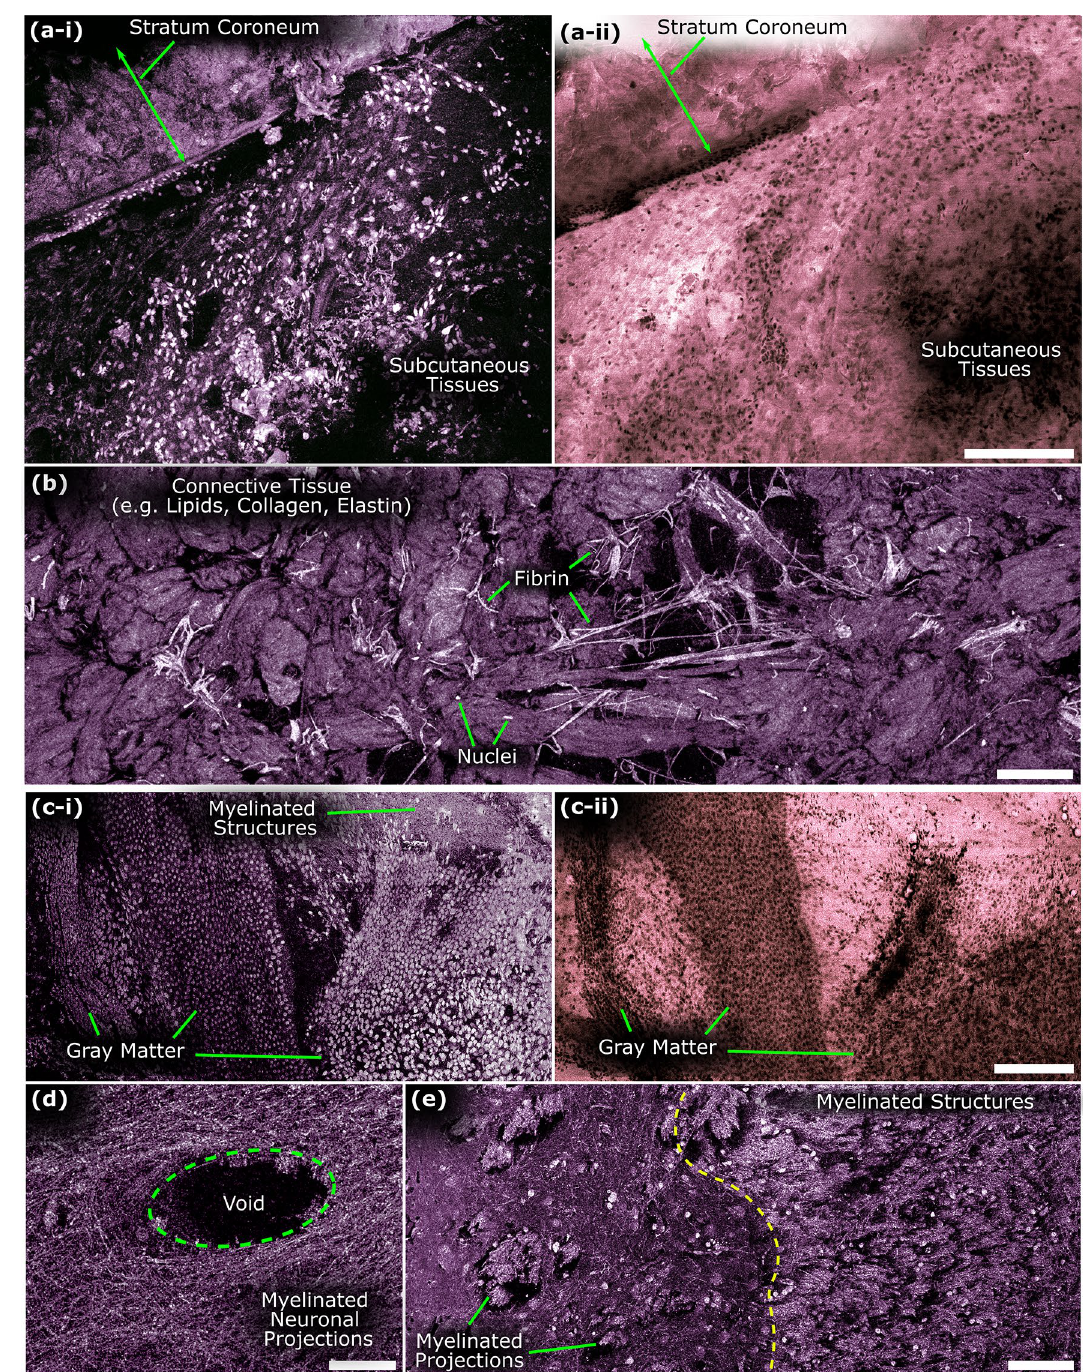
Figure 4. Total-absorption second-generation photoacoustic remote sensing (TA-PARS) microscopy of unstained and unprocessed resected tissue specimens. ( a ) Resected human skin tissues. ( a-i ) TA-PARS non- radiative absorption contrast. ( a-ii ) TA-PARS radiative contrast of the same region of tissues. Scale Bar: 200 µm ( b ) Deep subcutaneous connective tissues of resected human skin tissues with elongated strings of fibrin. Scale Bar: 100 µm. ( c ) TA-PARS image of unprocessed resected Rattus brain tissues ( c-i ) TA-PARS non-radiative absorption contrast. ( c-ii ) TA-PARS radiative contrast image of the same region. Scale Bar: 200 µm ( d ) TA-PARS non-radiative absorption contrast image highlighting apparent myelinated structures within the brain tissues. Scale Bar: 50 µm ( e ) TA-PARS non-radiative absorption image of the boundary between two regions of brain tissues. Scale Bar: 100